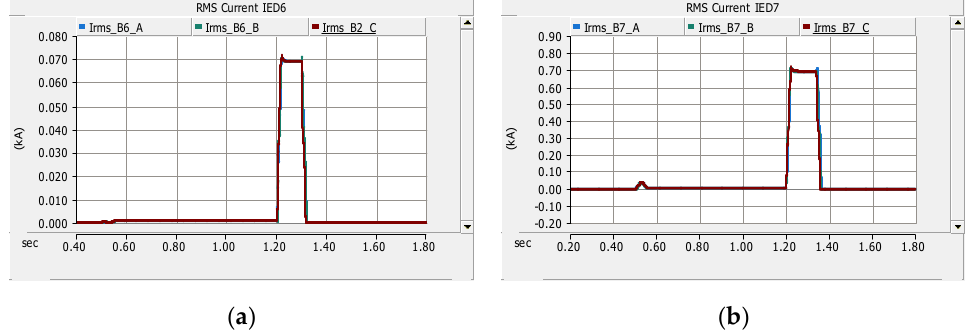
Figure 18. RMS current magnitude before, during and after fault F2 in the islanded mode at: ( a ) IED6 and ( b ) IED7 (IED7 direct transfer trip).